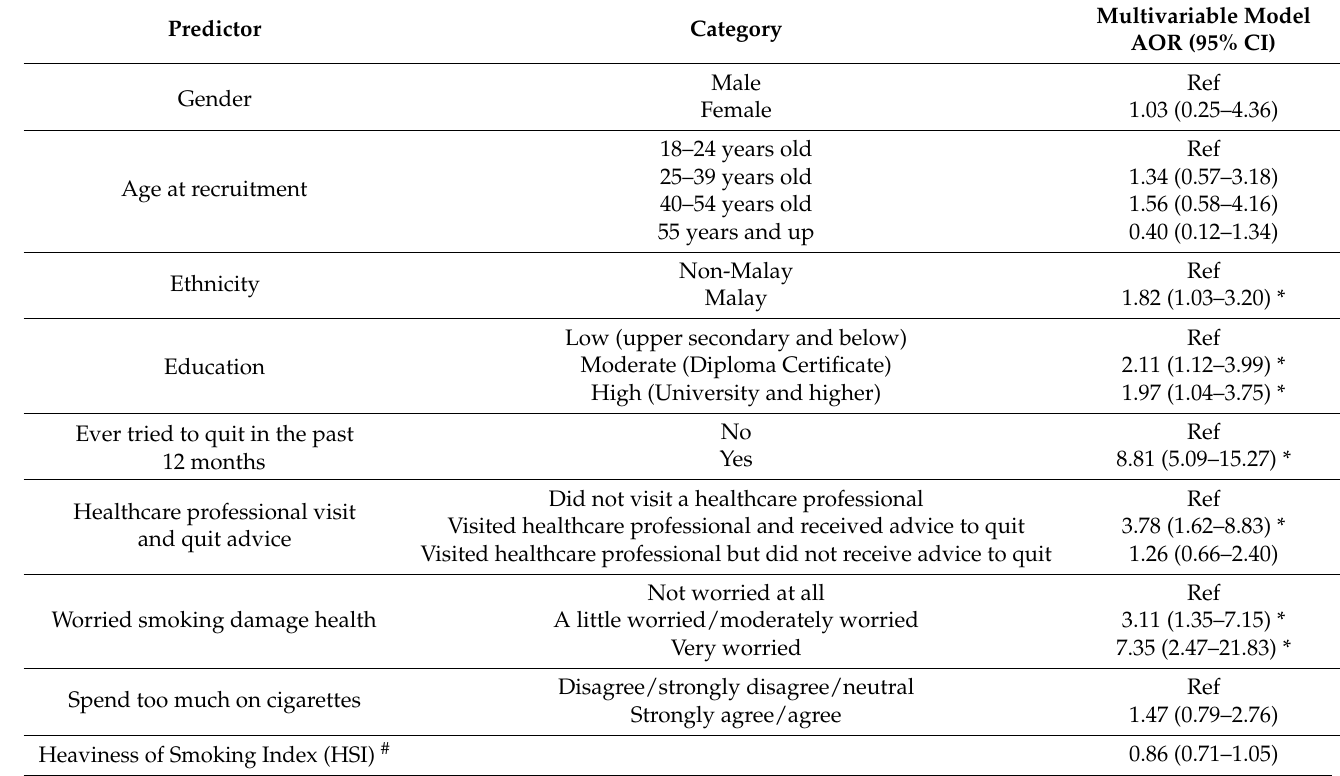
Table 3. Factors associated with intentions to quit smoking among Malaysian